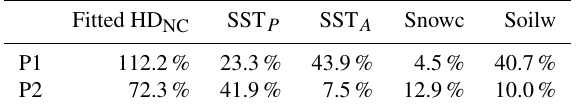
Table 2. The contribution rate of fitted HD NC and each external forcing factor to the trend of HD NC in P1 and P2,